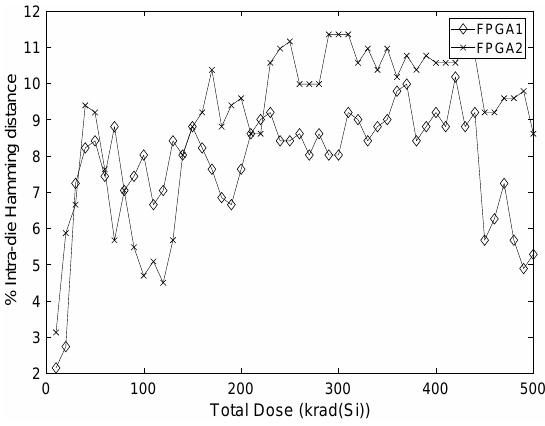
Figure 10. Reliability vs. radiation.